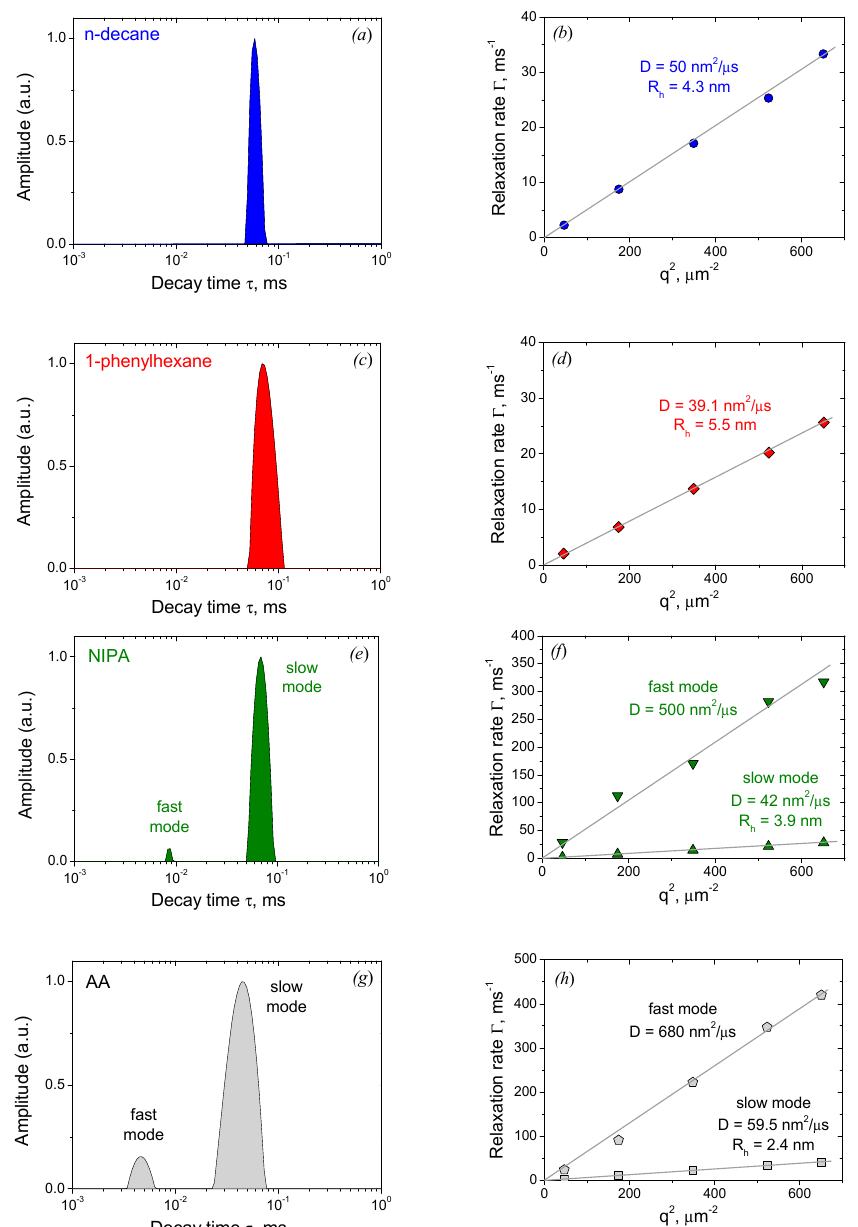
Figure 5. Decay time ( τ ) distributions (on the left) and dependences of relaxation rates ( Γ ) on the square of scattering vector q 2 (on the right) obtained by DLS for the solutions of 78 mM potassium oleate, 117 mM C8TAB and various additives: ( a , b ) 210 mM n-decane; ( c , d ) 250 mM 1-phenylhexane; ( e , f ) 620 mM NIPA; ( g , h ) 2810 mM AA. Solvent: KOH in D 2 O, pH 11. Temperature: 20 °C. Table 3. Approximate additive concentrations (mM) corresponding to different ranges of viscosity drop in Figure 2b.